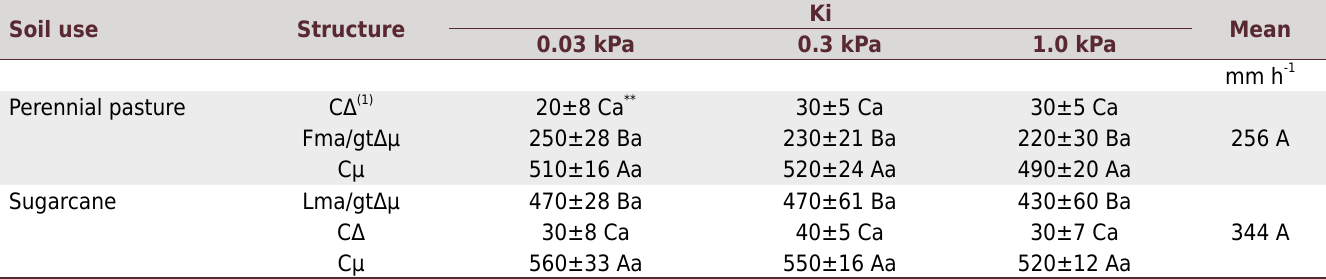
Table 3. Average hydraulic conductivity (Ki) in three Oxisol soil profiles under perennial pasture and sugarcane (± standard error) Soil use